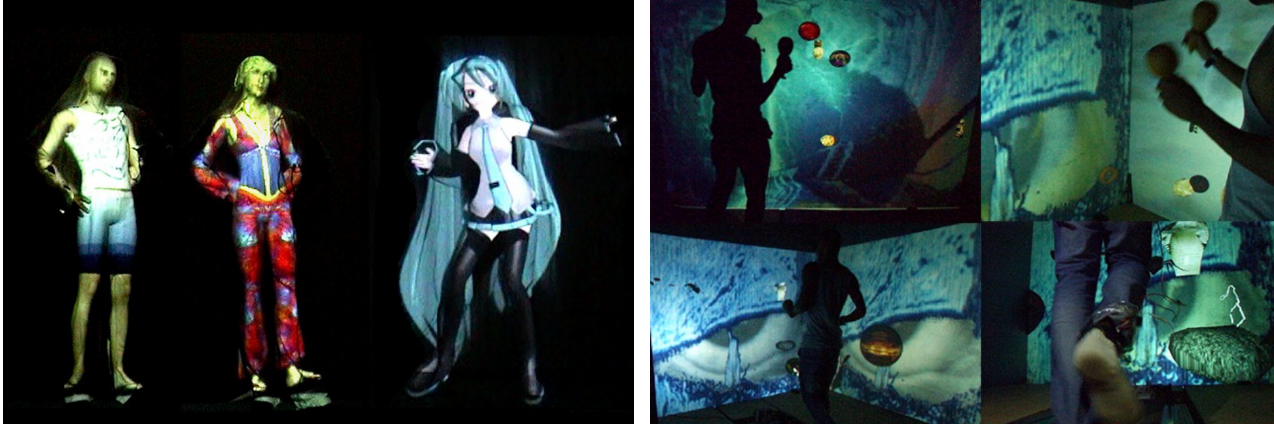
Figure 2: Embodied dialogue genre examples.